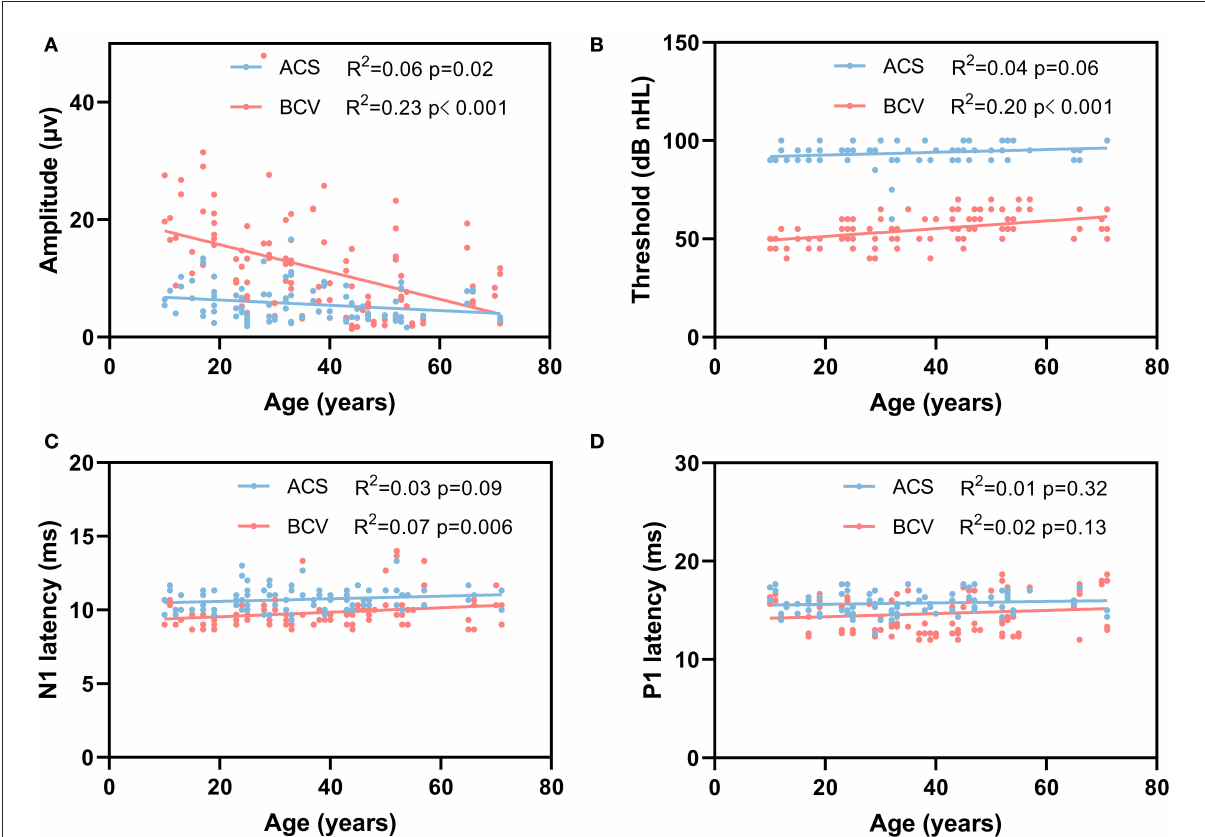
FIGURE3 Simple linear regression curves showed the relationship between age and oVEMP recording parameters. (A) A significantly negative correlation between age and amplitude for ACS ( p = 0.02) and BCV ( p < 0.001). (B) A significantly positive correlation between age and thresholds for BCV ( p < 0.001). (C) A significant positive correlation was found between age and N1 latency for BCV ( p = 0.006). (D) There was no correlation between the age and P1 latency for ACS and